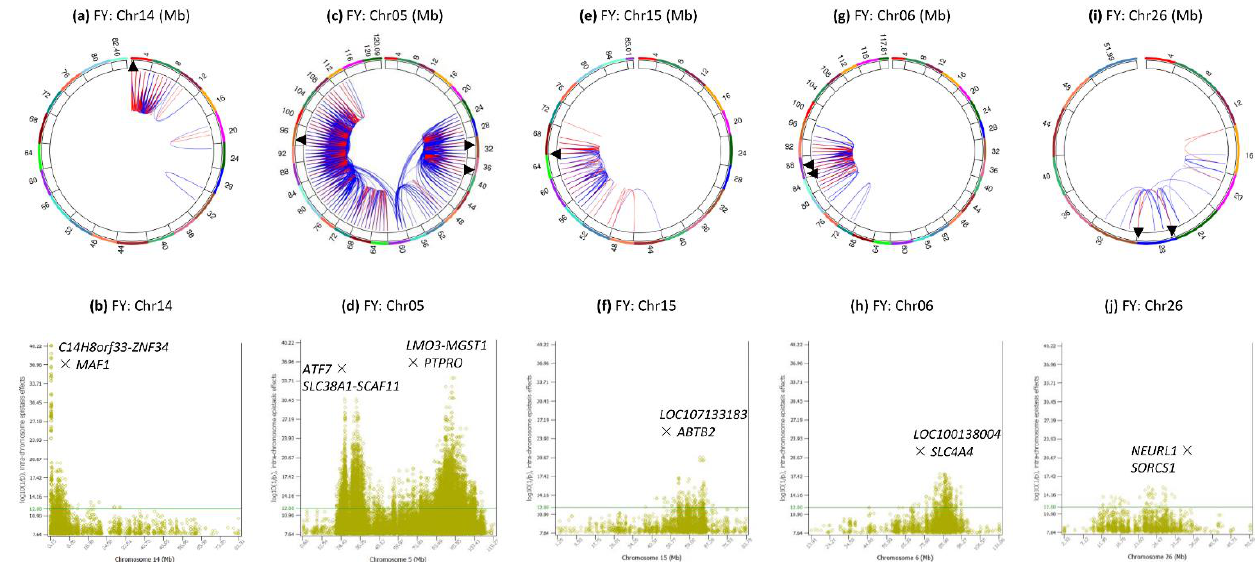
Figure 7. Chromosomes with most significant intra-chromosome epistasis effects for fat yield. The top row shows the circular plots with red color indicating intra-4 Mb epistasis effect and blue color indicating inter-4 Mb epistasis effects; the bottom row shows the Manhattan plots of log10(1/p) values, where p = the 5% genome-wide type-I error with the Bonferroni multiple testing correction. The black arrow indicates the location of the peak epistasis effect of the chromosome. Gene name indicates the gene with a peak SNP epistasis effect, and ‘ - ’ indicates the SNP was between the two genes. FY = fat yield. ( a ): Intra-chromosome epistasis effects of Chr14 for fat yield. ( b ): Statistical significance of intra-chromosome epistasis effects of Chr14 for fat yield. ( c ): Intra-chromosome epistasis effects of Chr05 for fat yield. ( d ): Statistical significance of intra-chromosome epistasis effects of Chr05 for fat yield. ( e ): Intra-chromosome epistasis effects of Chr15 for fat yield. ( f ): Statistical significance of intra-chromosome epistasis effects of Chr15 for fat yield. ( g ): Intra-chromosome epistasis effects of Chr06 for fat yield. ( h ): Statistical significance of intra-chromosome epistasis effects of Chr06 for fat yield. ( i ): Intra-chromosome epistasis effects of Chr26 for fat yield. ( j ): Statistical significance of intra-chromosome epistasis effects of Chr26 for fat yield.